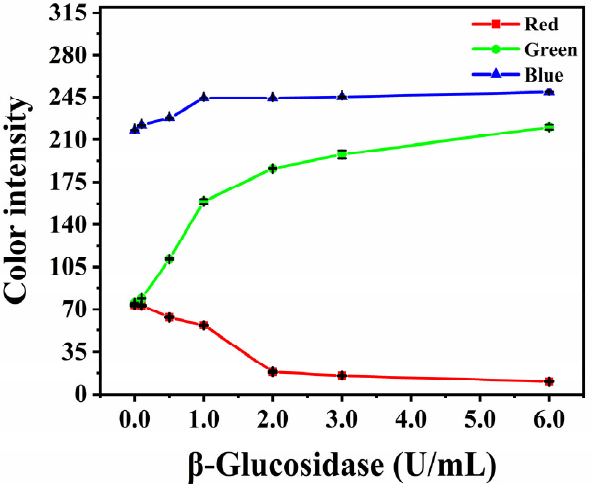
Figure 4. Intensity of RGB channels in fluorescent images irradiated by ultraviolet light at 365 nm of the paper ‐ based device with different activity of β‐ glucosidase.